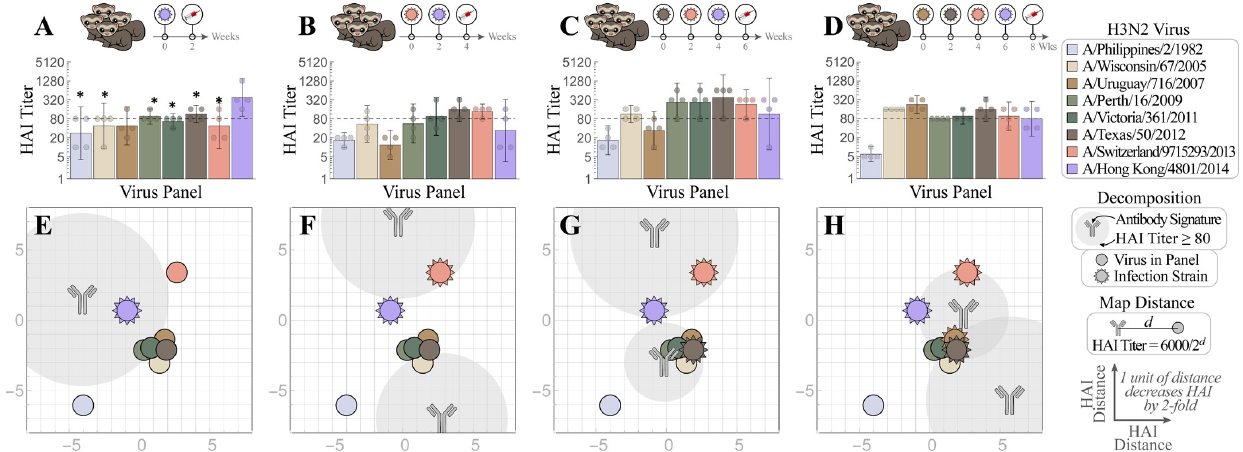
Figure 5. Mapping how exposure history shapes the ferret antibody response. Naïve ferrets were infected with ( A ) V 4 = Hong Kong 2014 , or with prior exposure to ( B ) V 3 = Switzerland 2013 , ( C ) V 2 = Texas 2012 , and ( D ) V 1 = Uruguay 2007 . All antisera were analyzed via HAI after the final infection with Hong Kong 2014. Individual HAI titers are shown from four ferrets (points) and geometric means (bar graphs) with 95% confidential intervals (error bars). * indicates p < 0.05 vs. Hong Kong 2014 by Mann–Whitney test after data were log transformed. ( E – H ) Each set of measurements was decomposed to determine the antibody signatures (the HAI profiles of the dominant antibodies within these sera). Each antibody signature (gray) is predicted to have an HAI titer ≥ 80 against any virus within the gray circle, with the size of this circle proportional to the fractional composition of the antibody signature within the serum. An antibody–virus distance d denotes an HAI titer of 6000/2 d .